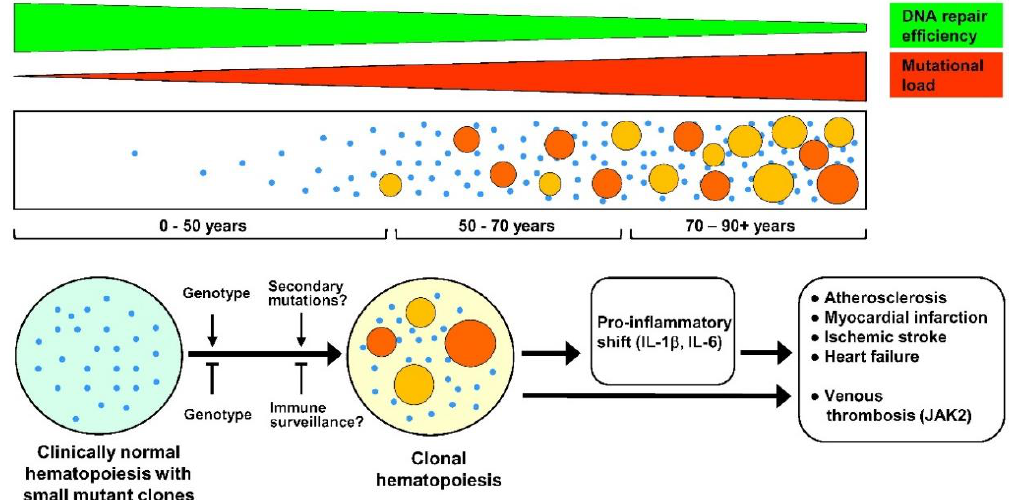
Figure 1. Suggested timeline of clonal hematopoiesis (CH), potential factors a ff ecting it, and its clinical consequences. Upper tier: CH arises due to ongoing age-related somatic mutagenesis, which in turn is likely a result of a progressive decline of DNA repair mechanisms with aging [19–22]. Middle tier: age-relevant accumulation of small-size mutant clones followed by progressive appearance of the large-size ones, resulting in clinically relevant CH. Age 0–50 years : Cases of CH are very rare, although progressive age-dependent appearance of very small mutant clones (depicted as small blue dots) in at least some individuals is likely. Age 50–70 years : Very small size mutant clones are detected in 95% of the population, with usually several small clones per person [17]. In most subjects, these clones are fairly stable, and do not show many-fold expansion within 10–12 years [17]. However, in a part of the population (reaching about 20% by the age of 70 years), a strong expansion of some clones (depicted as larger-size orange and red circles) does occur, leading to a CH (defined as cases with clonal mutations greater than 0.02 variant allele fraction) with a potential clinical significance [16]. However, only 20% of these mutant clones are associated with mutations in candidate leukemia driver genes [16]. Age 70–90 + years : Further formation of small mutant clones is likely to occur, and large, clinically relevant mutant clones arise at increasing frequency, resulting in a more than 50% of CH prevalence in population by the age of 90 years [16]. Bottom tier: Although factors a ff ecting the expansion of very small mutant clones to clinically relevant large ones are currently unknown, the genetic background must have a significant role, both in promoting and inhibiting expansion. In addition, one might presume that secondary mutations advance clonal expansion, whereas immune surveillance helps to keep mutant clones at bay. A clonal drift in the aging hematopoietic system cannot be excluded as well (not depicted). Negative e ff ects of CH in cardiovascular diseases are gene-specific, but have a common denominator, namely pro-inflammatory shift due to enhanced production by mutant cells of inflammatory cytokines such as IL-1 β (interleukin 1 beta) and IL-6 (interleukin 6). This, together with enhanced production of myeloid cells, accelerates atherosclerosis and, consequently, increases risks of myocardial infarction and ischemic stroke. These factors also contribute to cardiac fibrosis and resulting heart failure. JAK2 (Janus kinase 2) mutations, in addition, strongly enhance risks of venous thrombosis, predominantly due to increased production of thrombocytes and erythrocytes and neutrophil extracellular trap